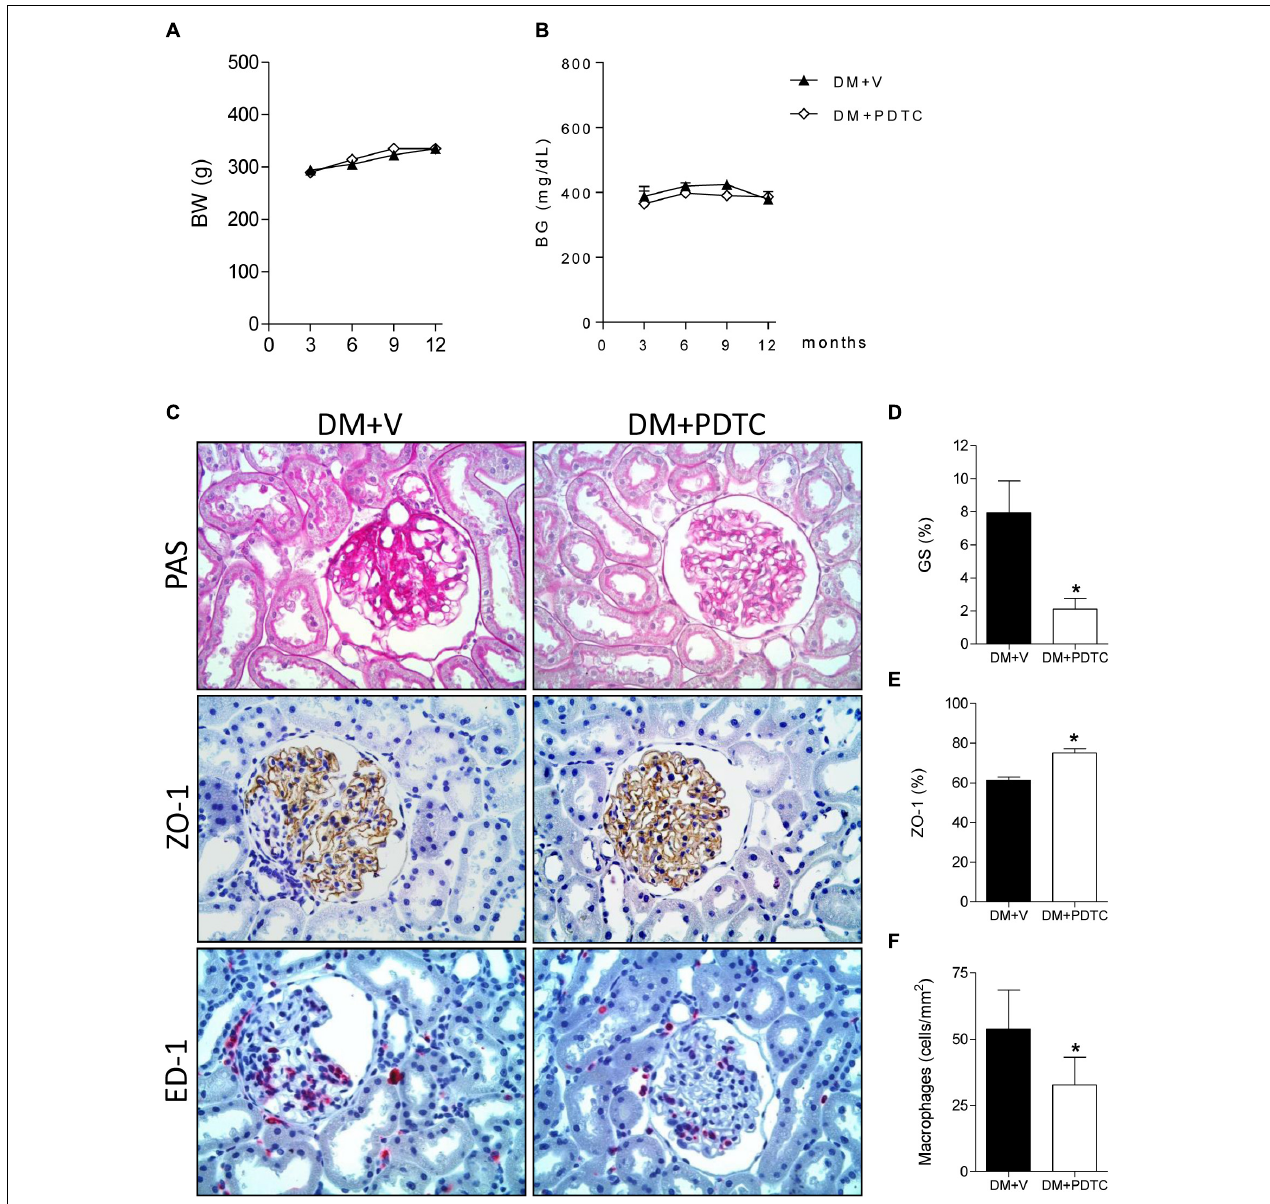
FIGURE 6 | Time course of (A) body weight (BW, g) and (B) blood glucose concentration (BG, mg/dL) in rats treated with the NF- κ B inhibitor pyrrolidine dithiocarbamate (Group DM+PDTC, n = 11) or vehicle (Group DM+V, n = 16) for 12 months. In panel (C) , illustrative microphotographs ( × 400) of glomerulosclerosis in PAS-stained renal tissue and detection, by immunostaining, of zonula occludens-1 (ZO-1) (brown), and macrophage (ED-1) (red) in renal tissue at 12 months of DM. Quantification of (D) frequency of glomeruli with sclerotic lesions (GS,%), (E) percent area of ZO-1 and (F) macrophage density (ED-1, cells/mm 2 ) in the glomerular area at this time. Results expressed as means ± SE. * p < 0.05 vs.